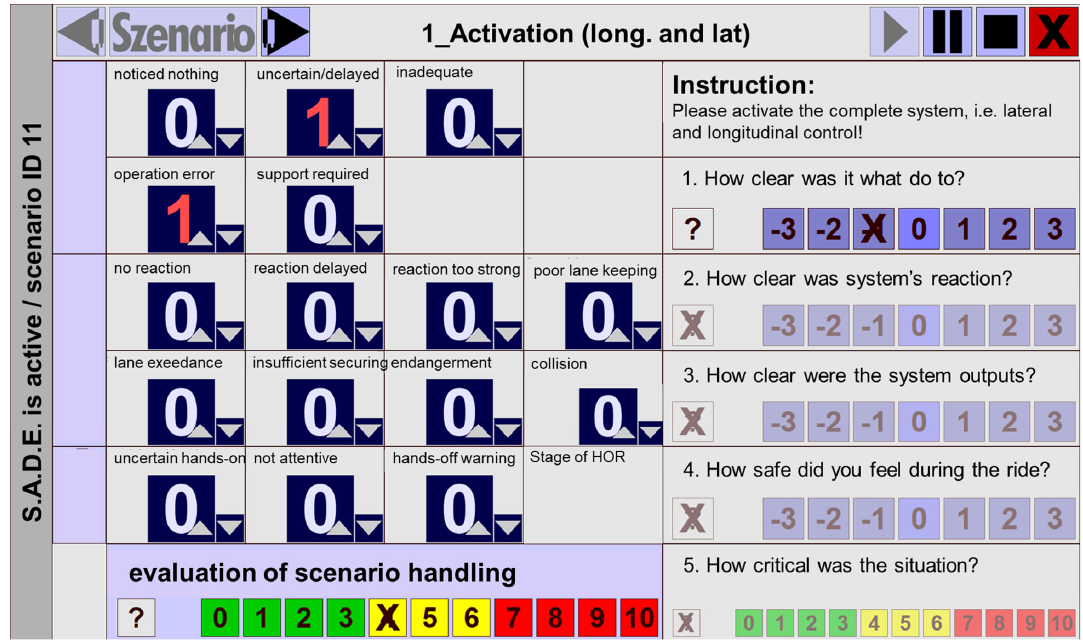
Figure 2. Tablet surface of the S.A.D.E.